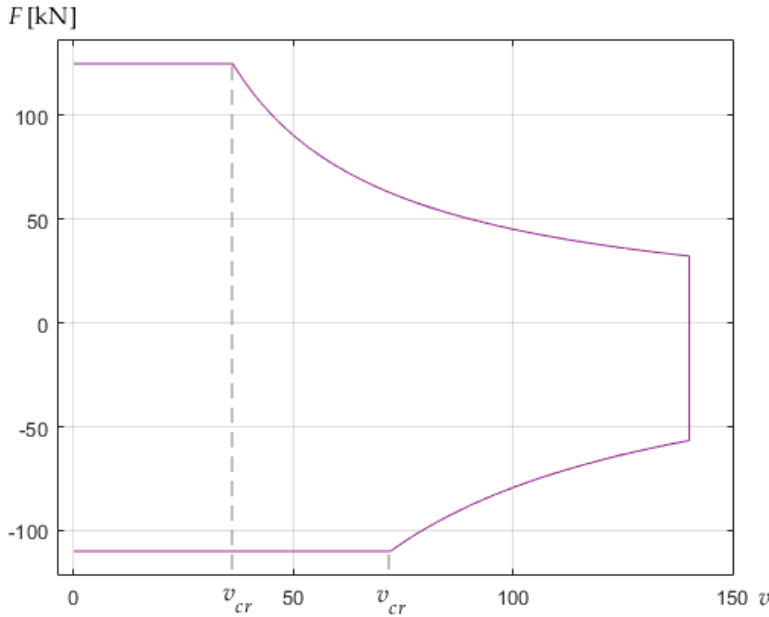
Figure 3. Traction properties of the train.